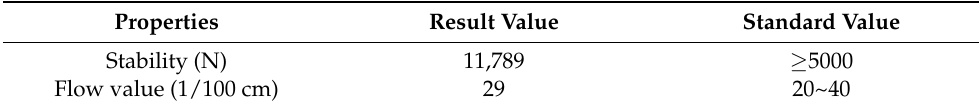
Table 4. General properties of guss mastic asphalt mixture (1%